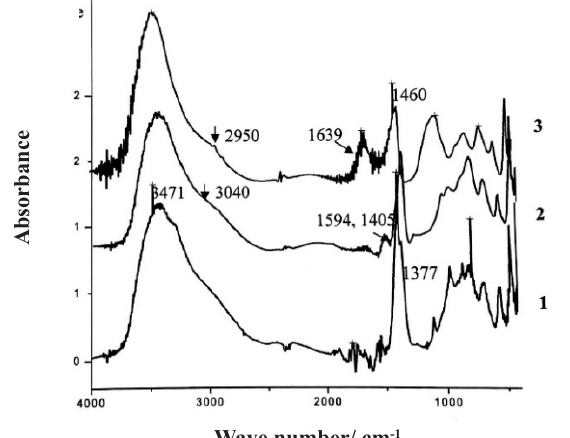
Figure 3.b: (1) Mg/ Al CO 32- LDH (2) Glutamate pillared LDH (3) Covalently linked trypsin within GP